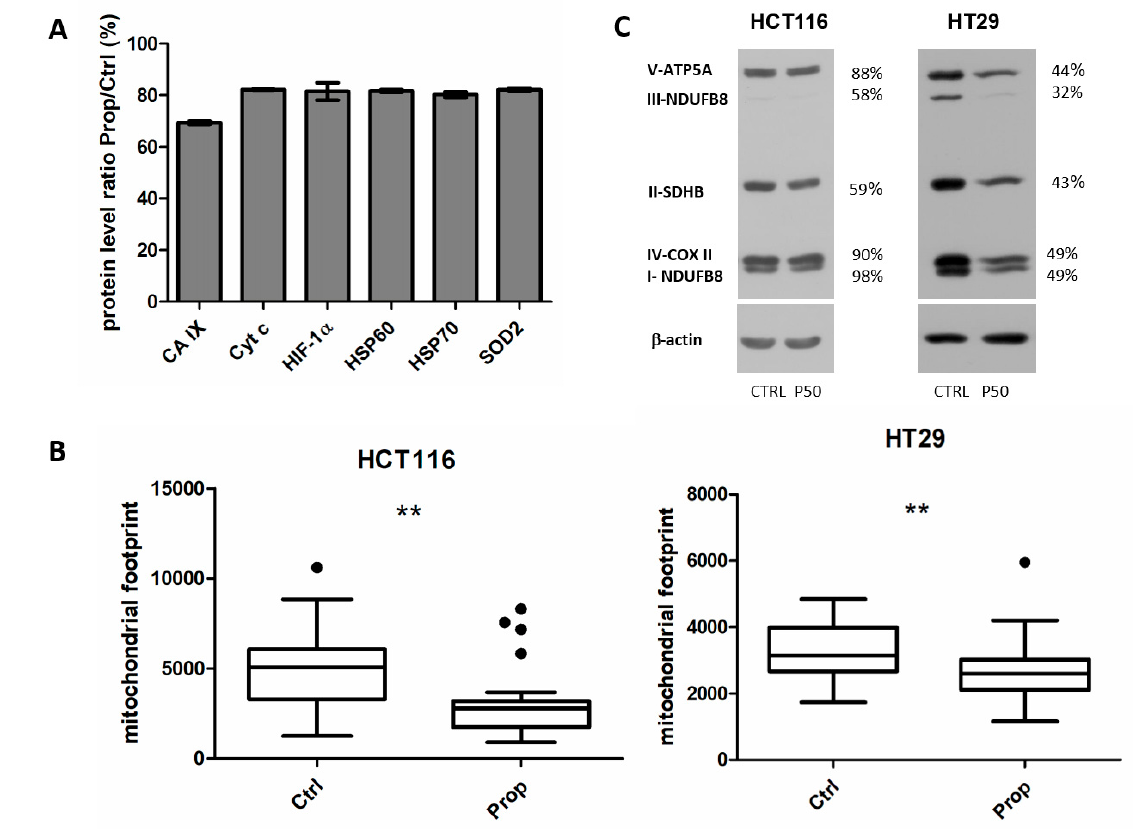
Figure 6. Propranolol reduces number of mitochondria and mitochondrial ox-phos enzymes. ( A ) Cell stress related proteins di ff erentially expressed in spheroids after beta-blockade by propranolol. Using the Proteome Profiler Human Cell Stress Array Kit we analysed protein lysates from 15 spheroids from HCT116 cells treated for 5 days with propranolol and appropriate controls. The screening analysis showed 6 di ff erentially expressed proteins. The results confirmed decreased levels of HIF1 α and CA IX and of other proteins involved in mitochondrial metabolism and in oxidative phosphorylation. ( B ) Analysis of the amount of mitochondria using a Mito tracker MitoRed. Confocal analysis colorectal cancer cells monolayers cultured in hypoxia showed a decreased mitochondrial footprint, that is, the area of cell consumed by mitochondria signal, in samples treated by propranolol in both HCT116 and HT29 cells. Images were processed by MiNA toolset in ImageJ 1.41g. Box plot graphs of the measurements of at least 40 control and treated cells are displayed (** p < 0.01). ( C ) Western blot analysis of oxidative phosphorylation (OXPHOS) proteins in spheroid samples from HCT116 and HT29 cells. After propranolol treatment, the levels of proteins essential for the process of oxidative phosphorylation were reduced. % values describe a di ff erence in the signal of propranolol treated samples in comparison to the controls set as 100%.